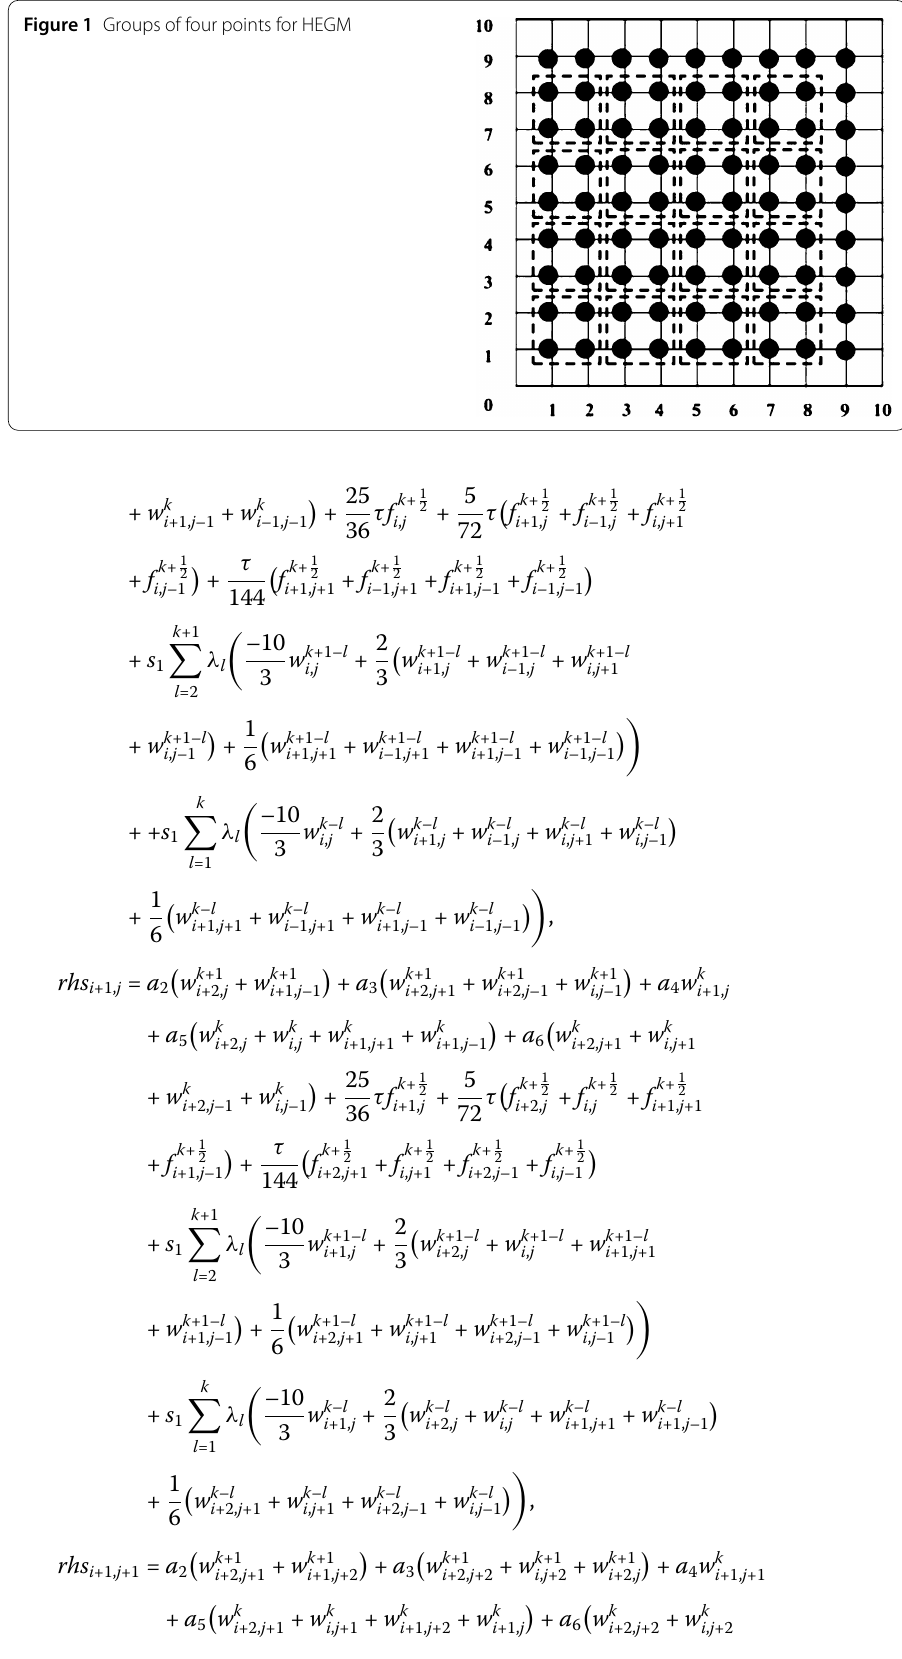
Figure 1 Groups of four points for